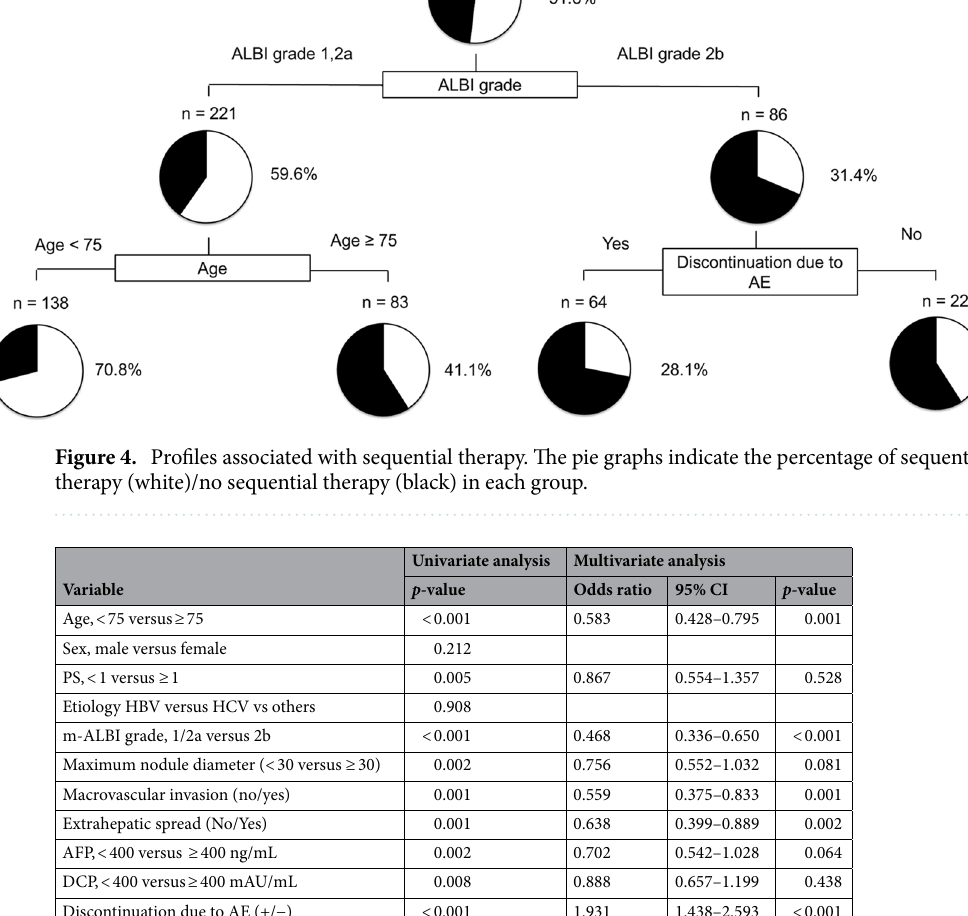
Table 4. Univariate and multivariate analyses of factors for OS. PS performance status, HBV hepatitis B virus, HCV hepatitis C virus, ALBI score Albumin-bilirubin score, BCLC Barcelona Clinic Liver Cancer, l AFP α-fetoprotein, DCP des-γ-carboxy prothrombin, AE adverse event.